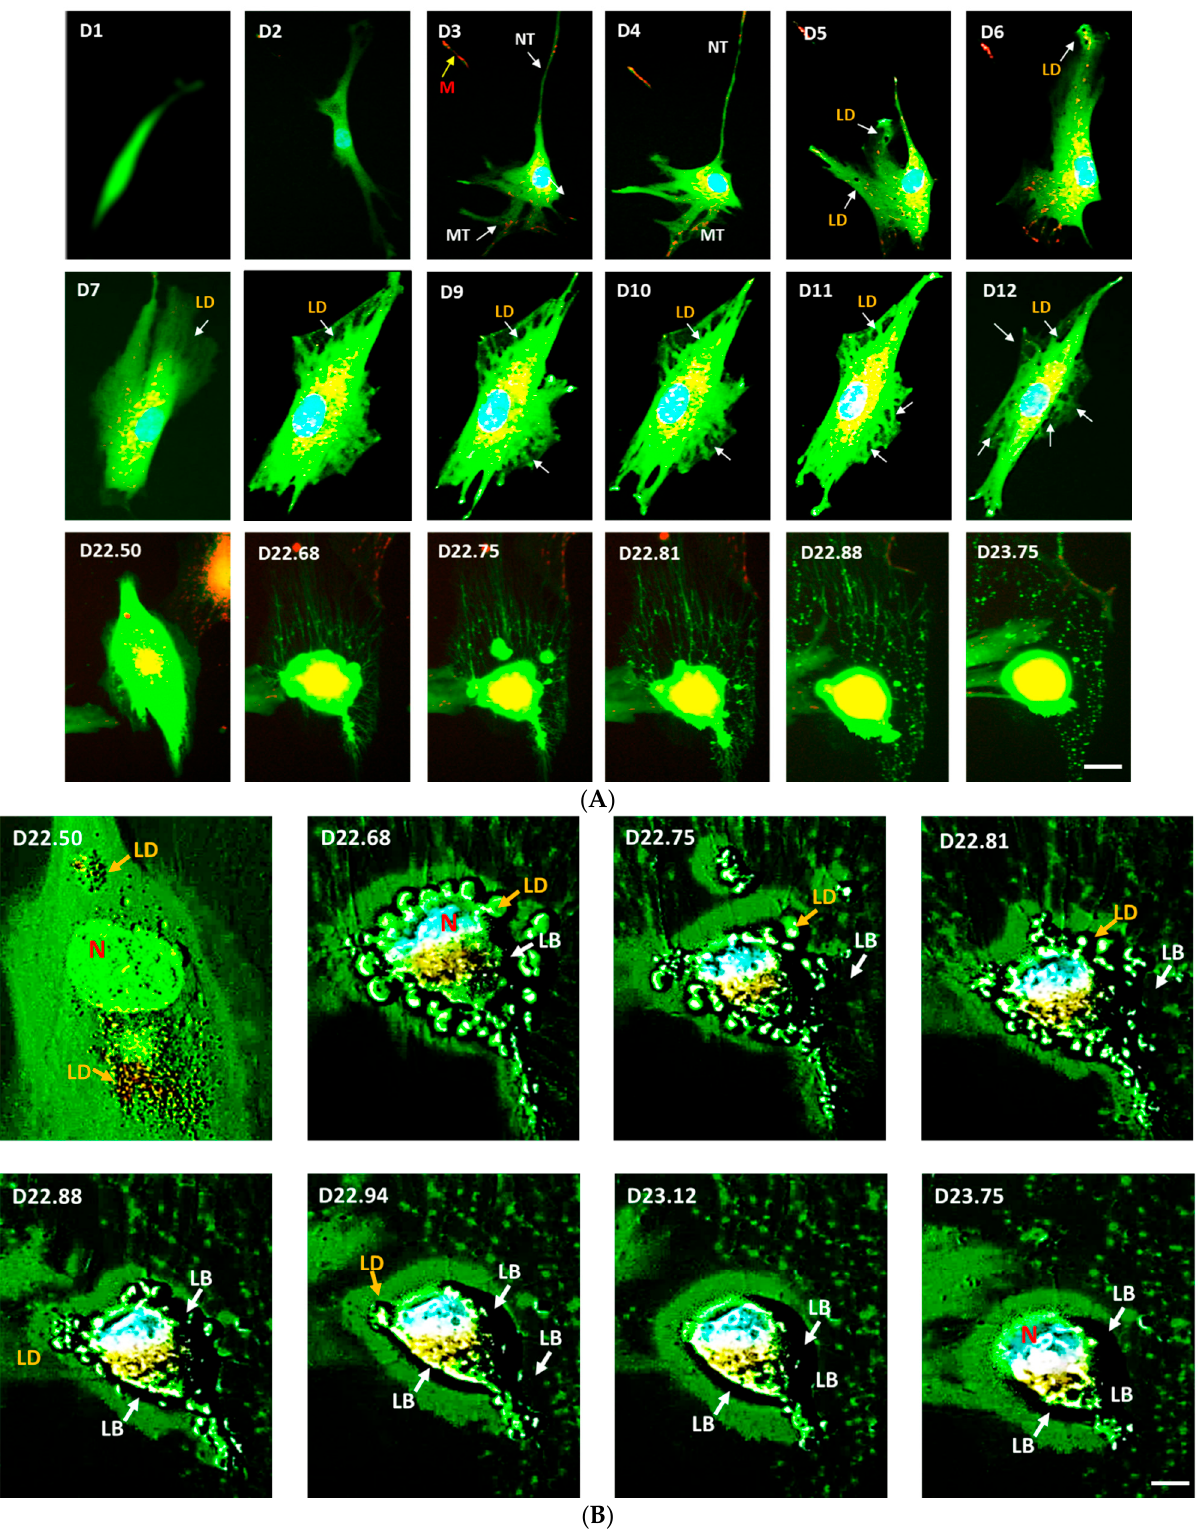
Figure 6. ( A ) Time-lapse fluorescence images of eNOS-KD-hMSCs cultured in the presence of cell-free mitochondria purified from control hMSCs from days 1 to 24: cell-free mitochondria purified from control hMSCs restore adipogenesis in eNOS-deficient hMSCs. Scale bar 10 µm. ( B ) Close-up time lapse fluorescence images of the culture in ( A ). LD: lipid droplets; LB : lipid bodies; D: day; N: nucleus.